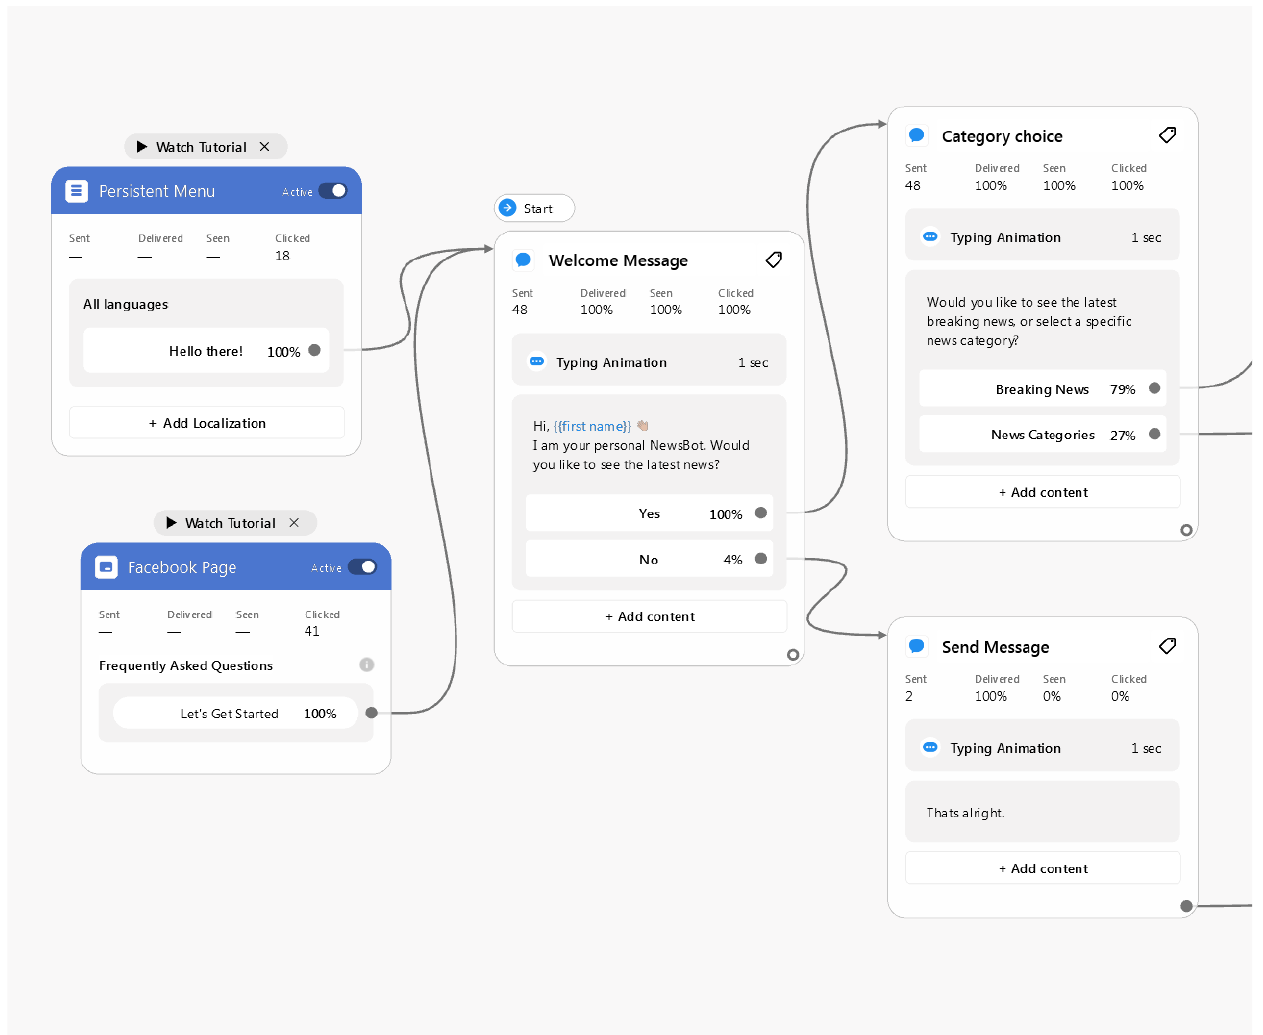
Figure 4. The chatbot creation interface of Chatfuel. “Blocks” are interconnected similarly to a flow diagram.